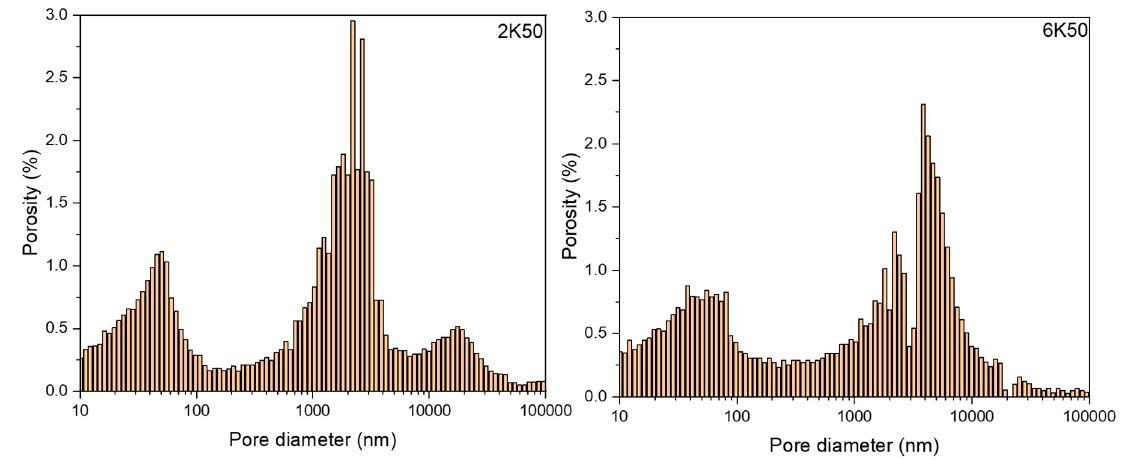
Figure 6. Pore size distribution in 2K50 and 6K50 samples.